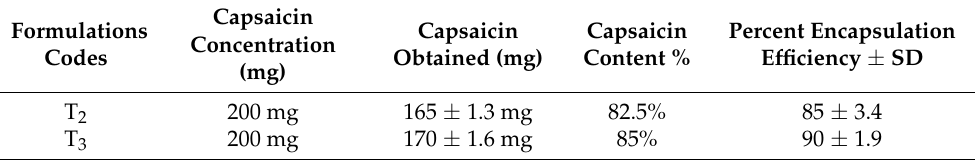
Table 3. Capsaicin content and encapsulation efficiency.